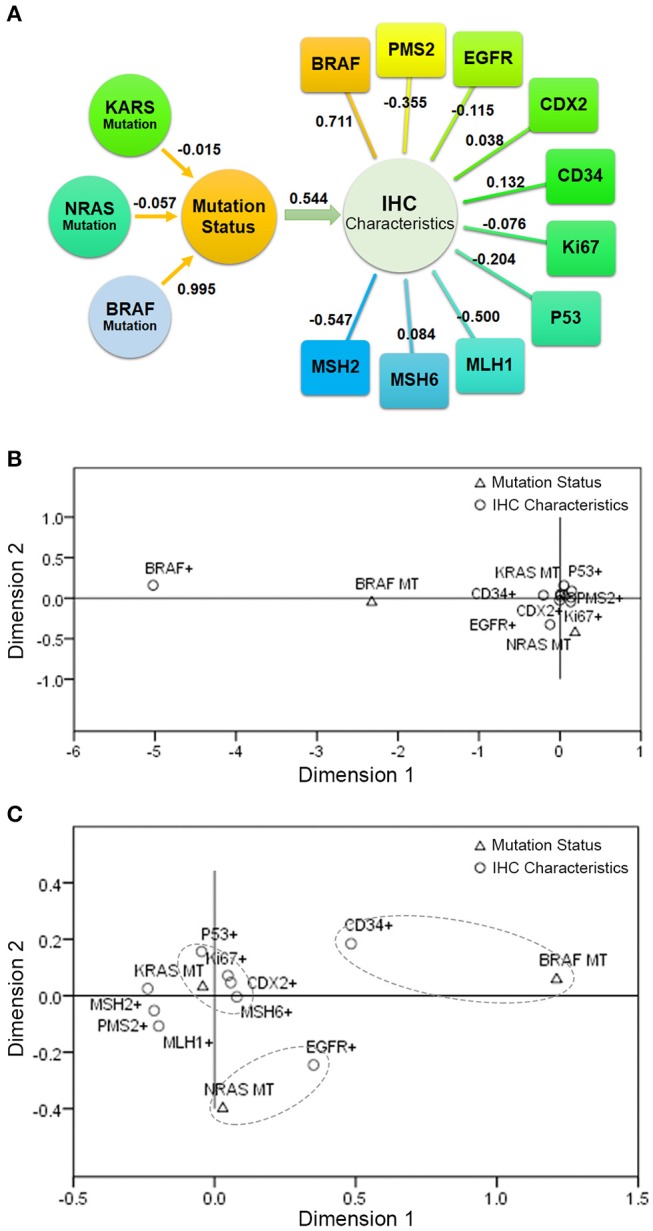
The correlation between KRAS/NRAS/BRAF mutation status and IHC characteristics in CRC. (A) The result of Canonical Correlation Analysis. (B) The result of Multiple Correspondence Analysis. (C) The result of Multiple Correspondence Analysis without the factor of BRAF (V600E) expression level.